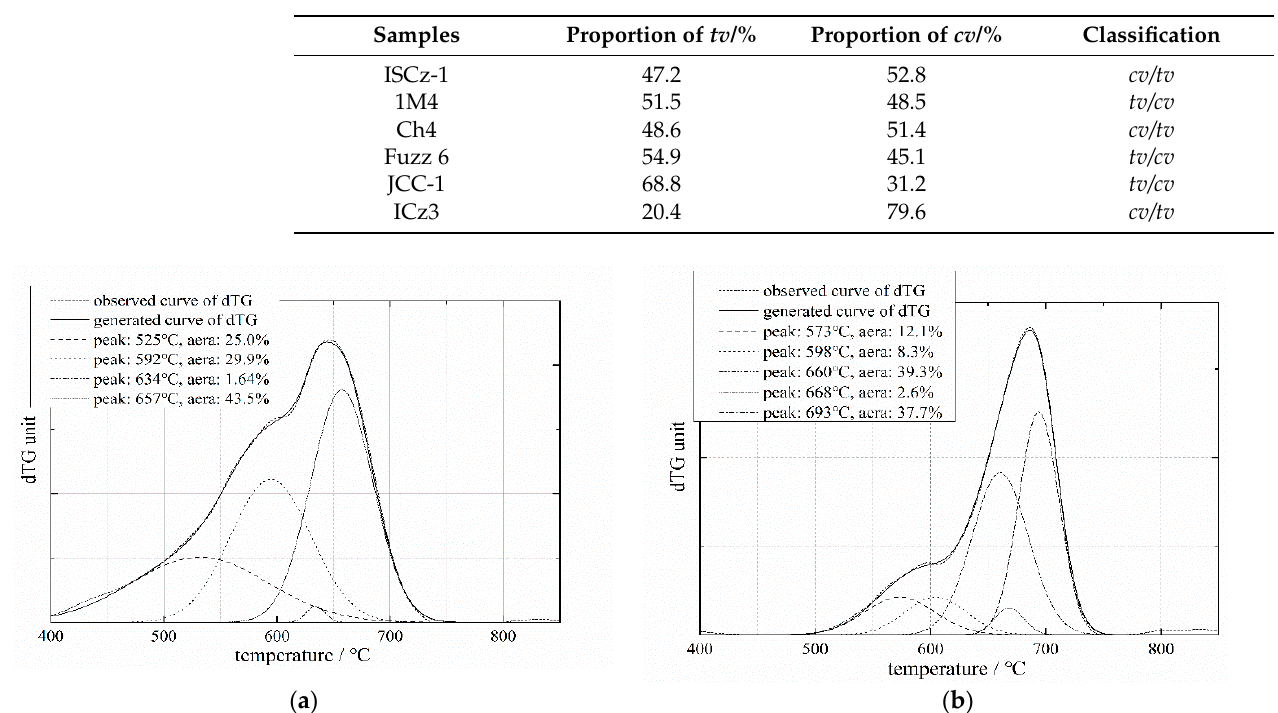
(Table 7). Table 6. Refinement results of oriented samples with different structure models. Models